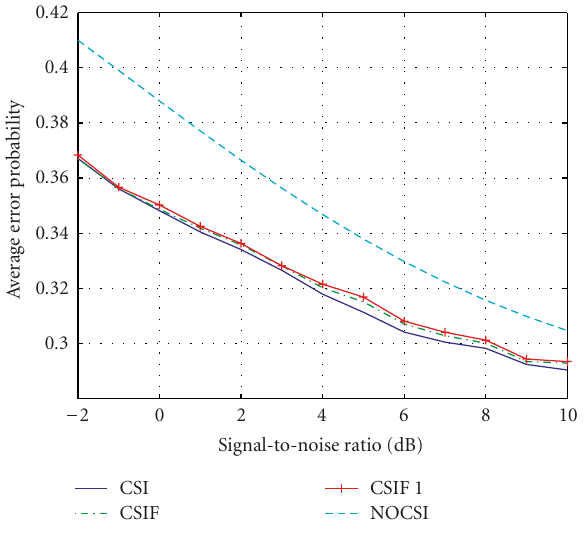
Figure 5: KL distance versus the local threshold at the local